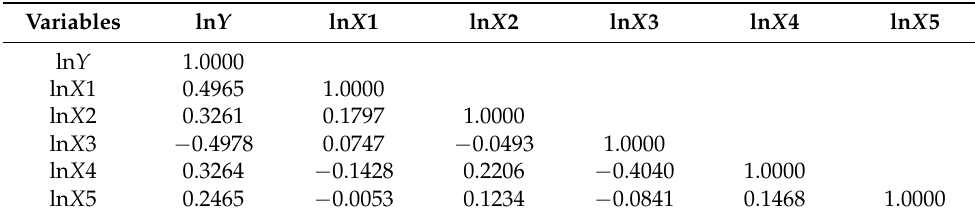
Table 5. Table of correlations among the